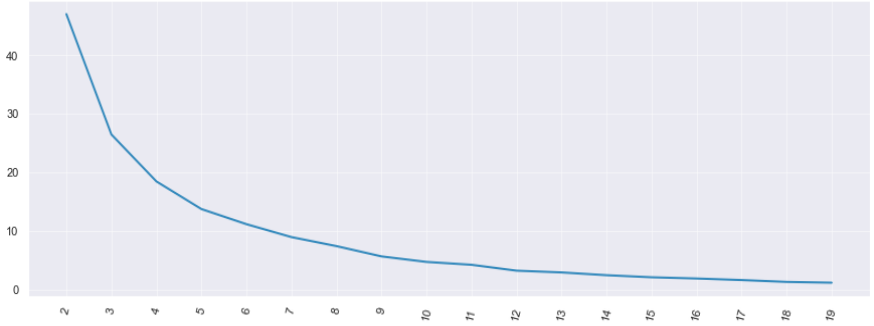
Figure 2. Sum of squared errors (SSE) within